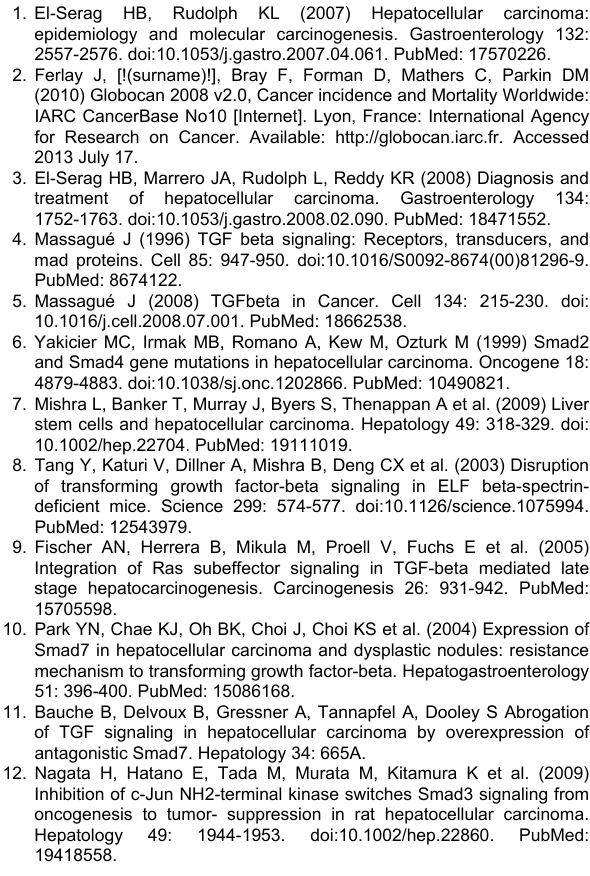
Figure S6. Densitometric analysis (ImageJ software) of Western Blots in Figure 6 and corresponding repetitive experiments. Results are shown as mean +/- SE of the indicated numbers of